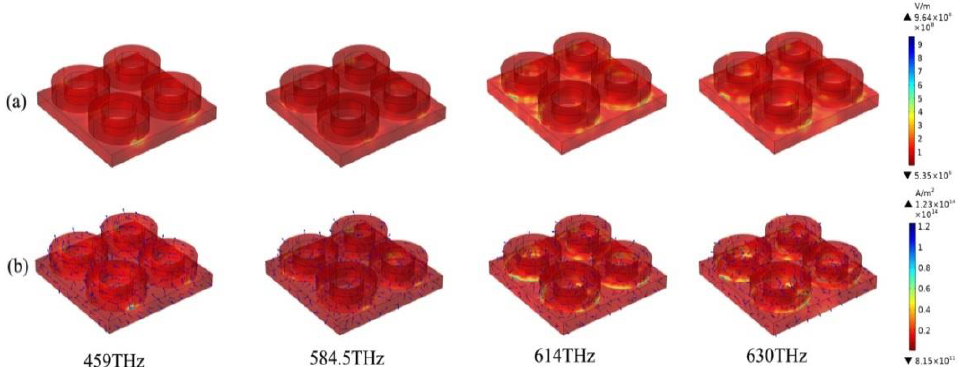
Figure 3. ( a , b ) The electric field and current distribution of the absorber in four resonant modes: 459, 584.5, 614, and 630 THz,.